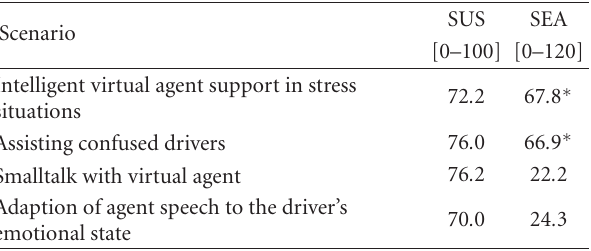
Table 1: Results for the System Usability Scale (SUS) and Sub- jectively Experienced E ff ort (SEA) scale for four selected tasks. SUS: maximum score is 100 (best usability), SEA: maximum score 120 (highest workload: worst), except for results marked with ∗ , where the maximum score of 120 indicates the maximum perceived decrease in workload (thus, 120 is